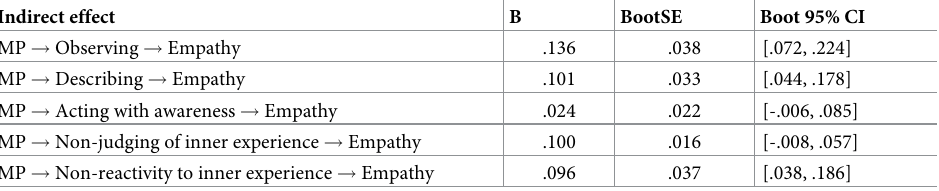
Table 2. Mediation model (PROCESS, Model 4): Indirect effect of mindfulness practice (IV) on empathy (DV), presenting the mediating impact of each mindfulness facets separately (mediating